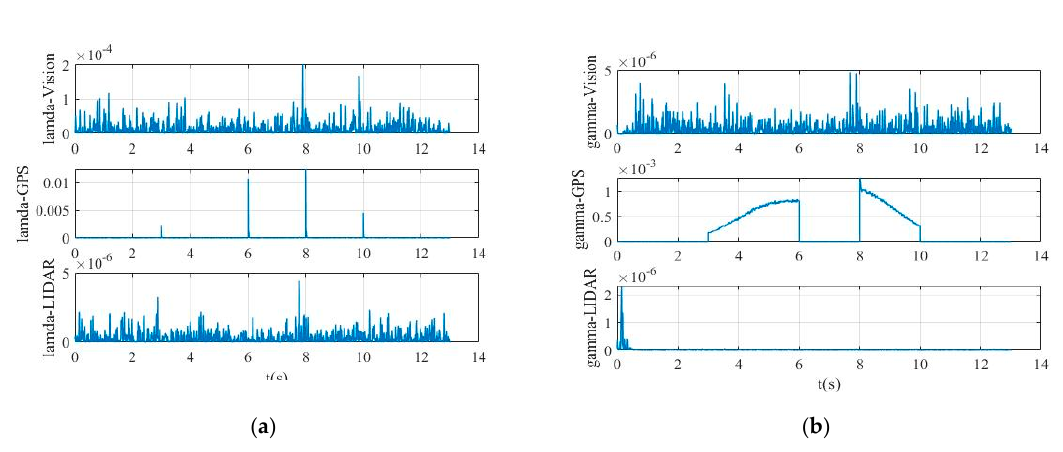
Figure 9. The changes of fault detection function for lateral positions based on: ( a ) double state chi-square detector; and ( b ) residuals chi-square detector.